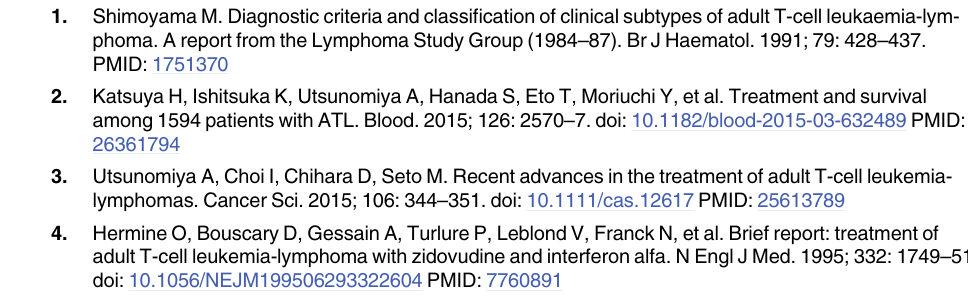
S4 Fig. Example staining for HLA-ABC, Tax, FoxP3 and PD-L1. (TIF) S5 Fig. PD-L1 and FoxP3 expression. (TIF) S6 Fig. Killing of ATL cells and non-malignant infected cells is inhibited in the presence of 20 nM Concanamycin A. (TIF) S7 Fig. Gating strategy for TCRV β flow cytometric analysis. (TIF) S8 Fig. Gating strategy used in cell survival assay. (A) Gating strategy used for multiparame- ter analysis (B) Gating strategy for absolute T cell counts.